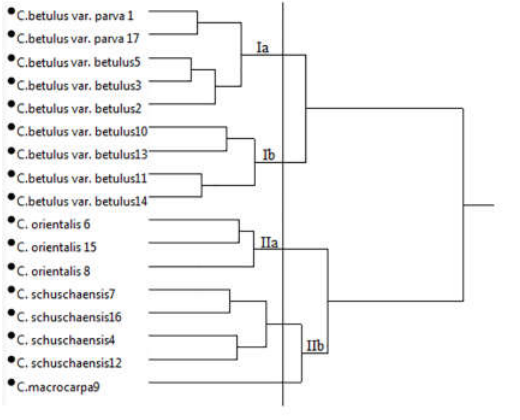
Fig. 2. Cluster analysis of Carpinus species based on quantitative and qualitative morphological data.